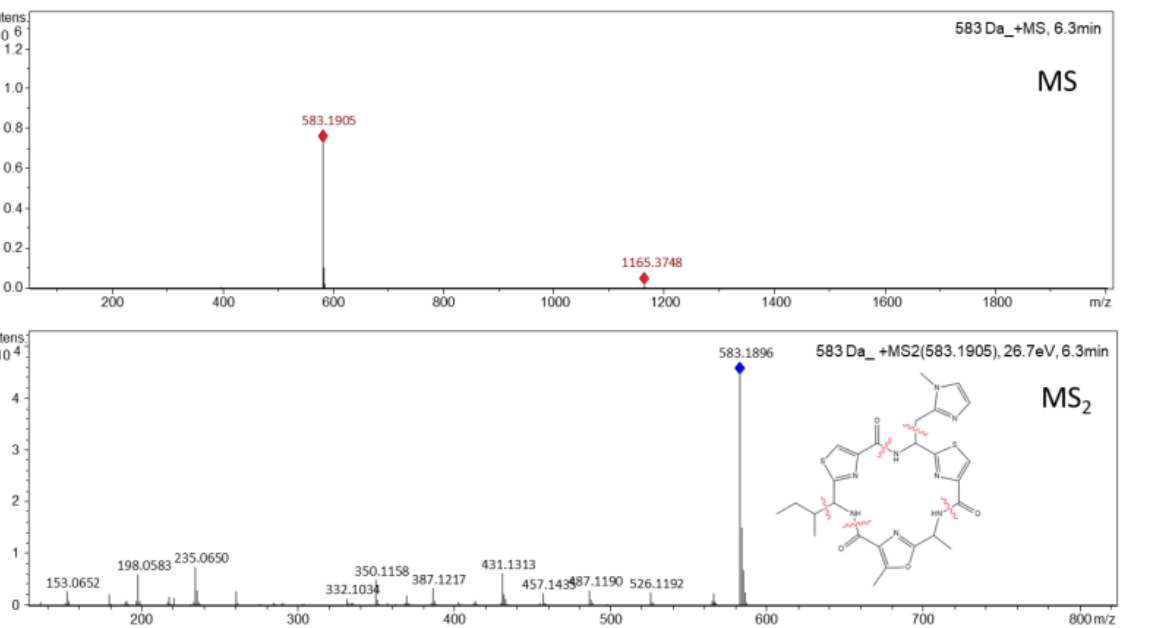
Figure 1. MS and MS 2 spectra obtained by LC-HR-ESI-QTOF-MS/MS for microcyclamide, m / z 583.